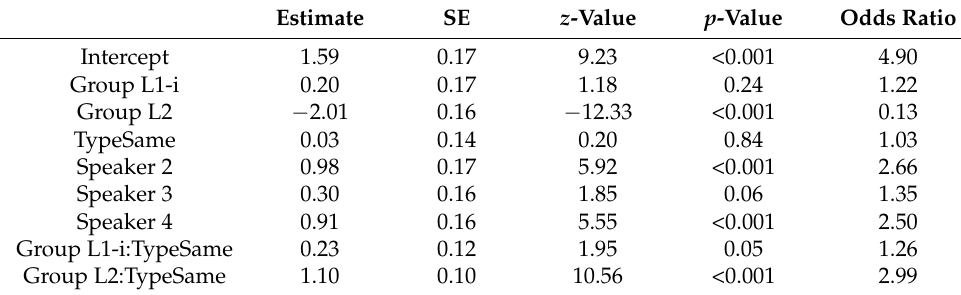
Figure 6. Bar plots of the average accuracy scores of each group by trial. ( a ) shows the average scores including both trial types, ( b ) shows the average scores in the same-word trials, and ( c ) shows the average scores in the different-word trials. Table 2. Results of the fixed effects of the first mixed-effects model.